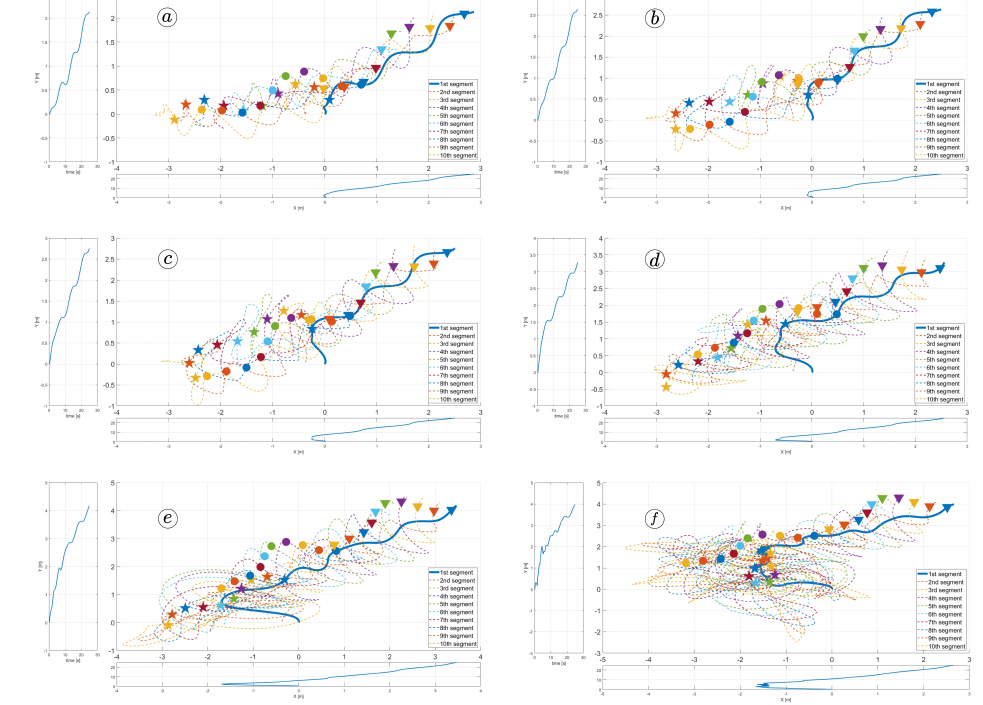
Figure 40. Trajectories of robot segments for k θ = 0.1 ( a ), k θ = 0.3 ( b ), k θ = 0.5 ( c ), k θ = 1 ( d ), k θ = 2 ( e ), and k θ = 3 ( f